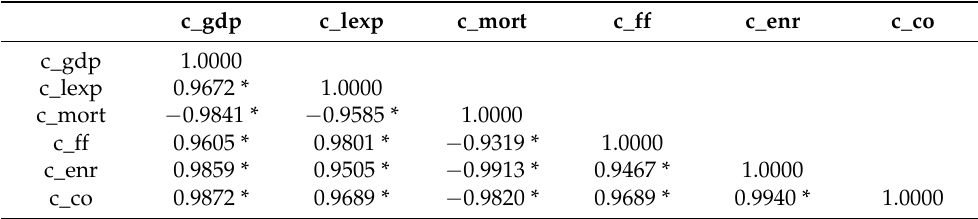
Table 2. Correlation matrix of China.